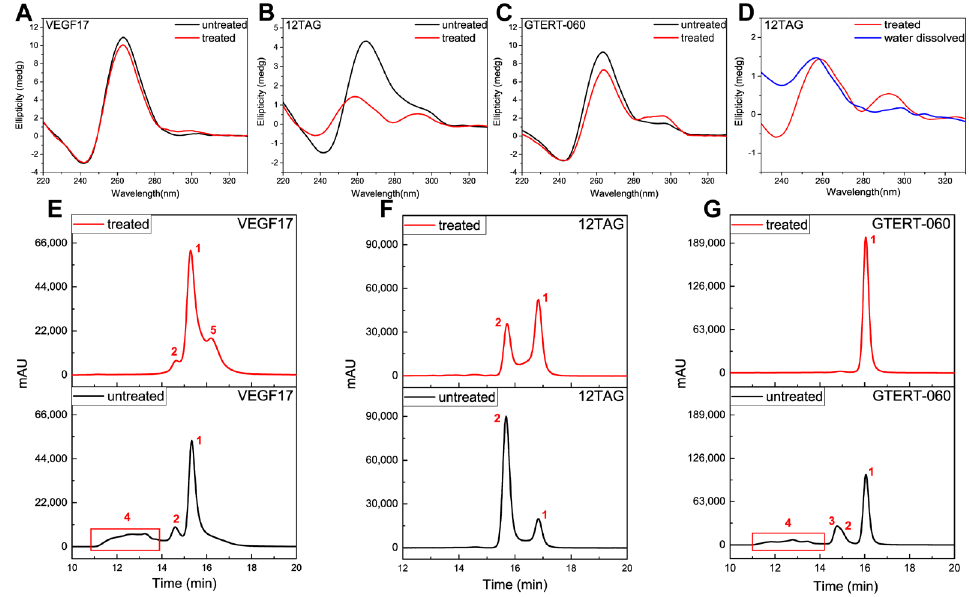
Figure 4. CD spectra and SEC chromatograms of ( A , E ) VEGF17, ( B , D , F ) 12TAG and ( C , G ) GTERT-060 without and with chemical treatments. Chromatograms were obtained under isocratic mode at the rate of 0.5 mL min −1 on a TSKgel G2000SW XL column (7.8 × 300 mm i.d.) with 50 mM KH 2 PO 4 as mobile phase. The concentrations of G4s were 10 μM . The column temperature was maintained at 30 °C and the detection wavelength was 260 nm. Chemical treatment condition: treated G4s with KOH solution (0.5 M) for 5 min at room temperature, and then added HCl solution (0.5 M) to return the pH to neutral. The black line in ( B ) represented annealed 12TAG G4 without chemical treatment, and the red lines in ( B , D ) represented annealed 12TAG G4 after chemical treatment. The blue line in ( D ) represented unannealed 12TAG which was directly dissolved in water and in ssDNA